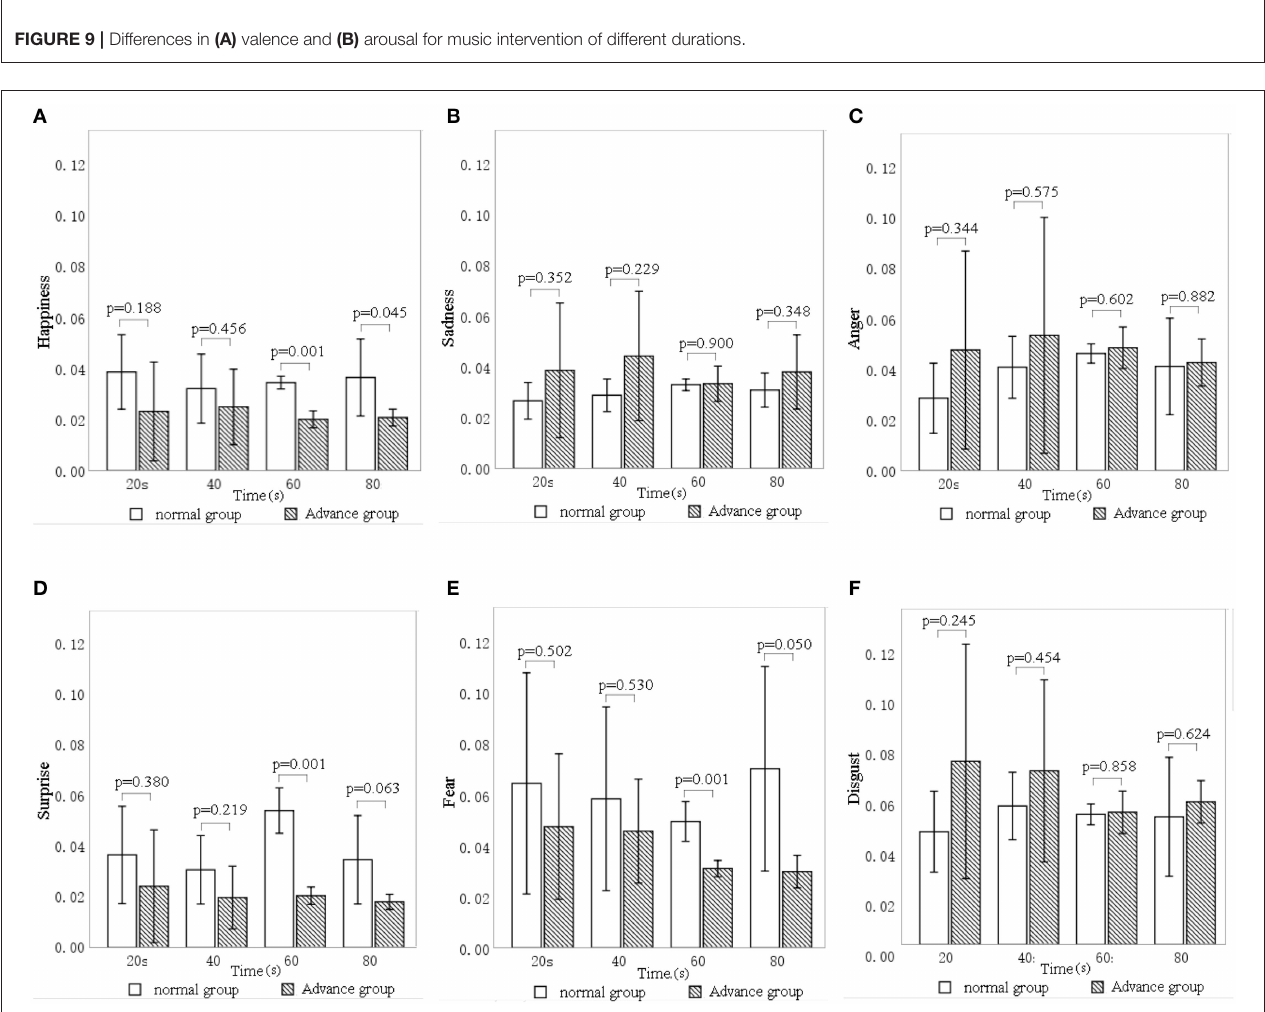
FIGURE 10 | Differences in facial expression indices— (A) happiness, (B) sadness, (C) anger, (D) surprise, (E) fear, (F) disgust—for different intervention durations.